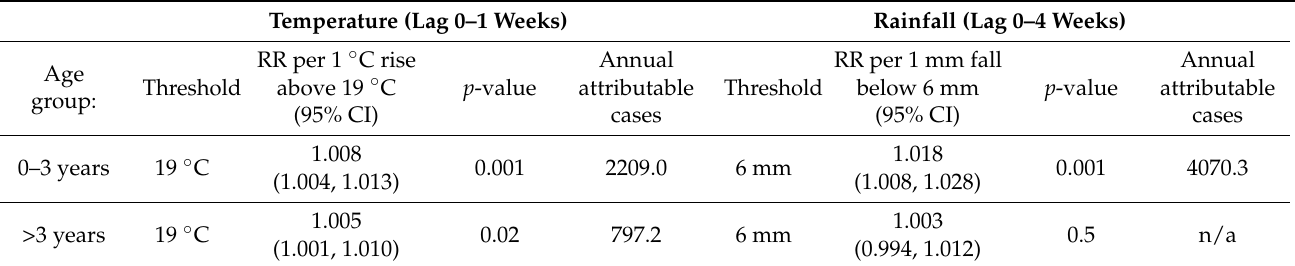
Figure 3. Seasonally adjusted relationship between ( a ) temperature and ( b ) rainfall with relative risk of diarrhoea presentation in the 0–3-year age-group. Table 2. Thresholds, RR (95% CI) and annual attributable numbers of diarrhoea presentations associated with temperature or rainfall.